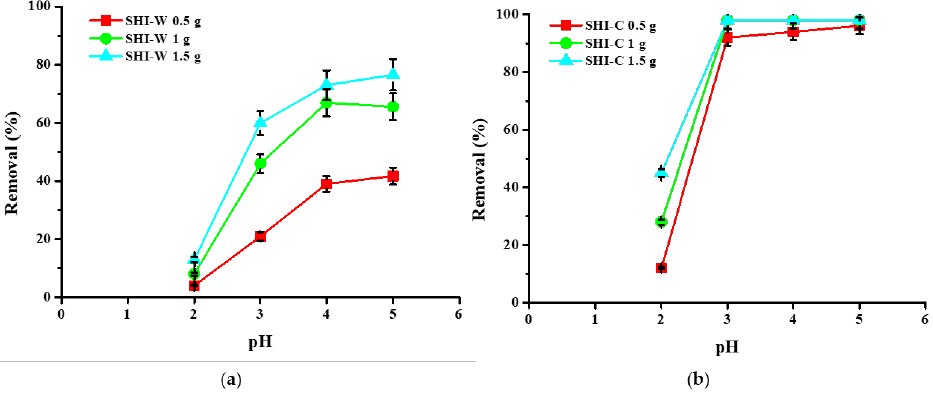
Figure 1. Influence of the initial pH of the solution on copper removal for three different doses of ( a ) washed hemp shives (SHI-W) and ( b ) Na 2 CO 3 activated hemp shives (SHI-C). Other experi- mental conditions: solution volume = 100 mL, [Cu 2+ ] = 25 mg/L, contact time = 120 min, stirring speed = 250 rpm, temperature = 22 ± 1 °C, n = 3.